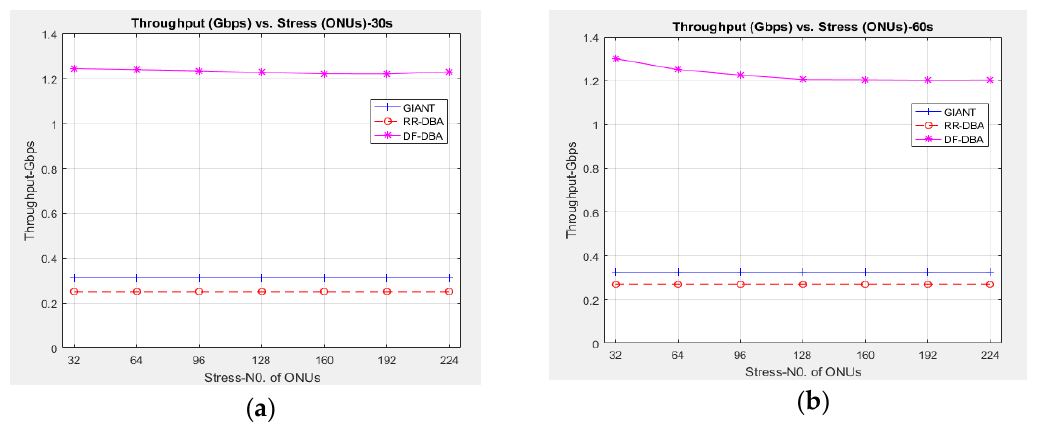
Figure 5. Throughput Analysis. ( a ) Throughput (Gbps) vs. Stress (ONUs)-30s ( b ) Throughput (Gbps) vs. Stress (ONUs)-60s.